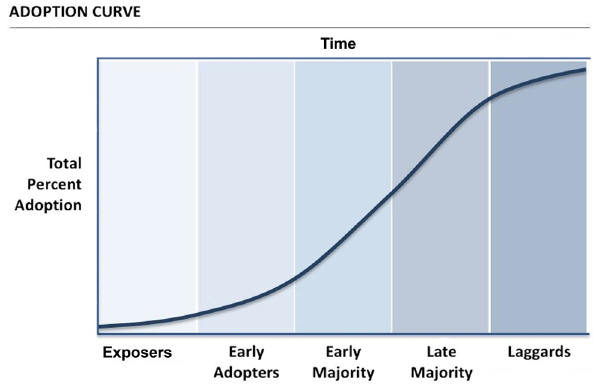
Figure 1: A typical adoption curve following di ff usion of innovation theory. The percentage of the population who have adopted an innovation is plotted against